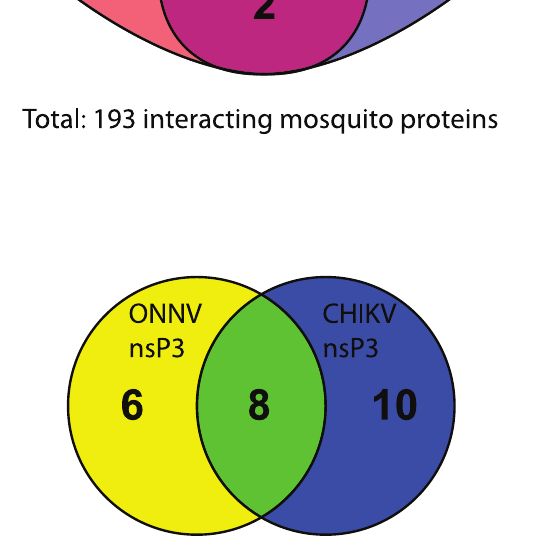
Fig 3. Venn diagrams of anopheline proteins that interact with ONNV nsP3 or CHIKV nsP3. GFP-HA was used to filter out proteins with non-specific binding. (A) Represents the number and overlap of proteins found in each precipitation with the GFP-HA tagged alphavirus nsP3s with either the opal stop codon, or the arginine readthrough. (B) Simplifies (A) by treating the opal and arginine variants as duplicates.